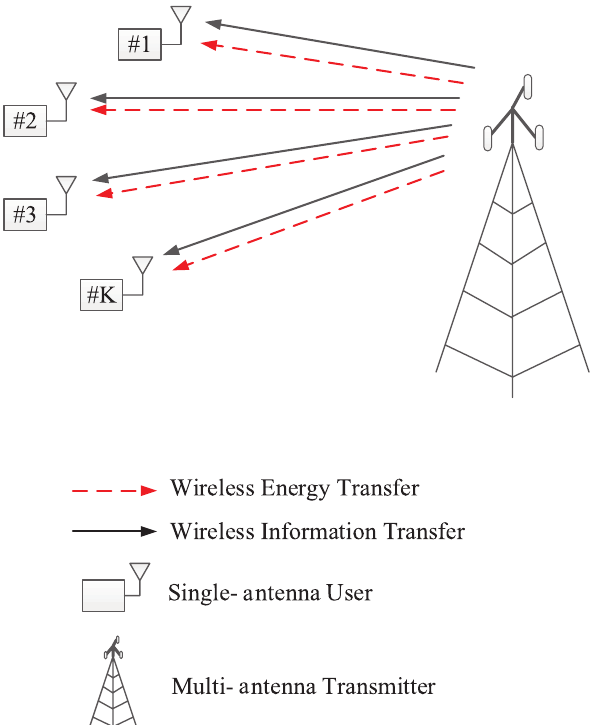
Figure 1. A network model of multi-user downlink communications based on